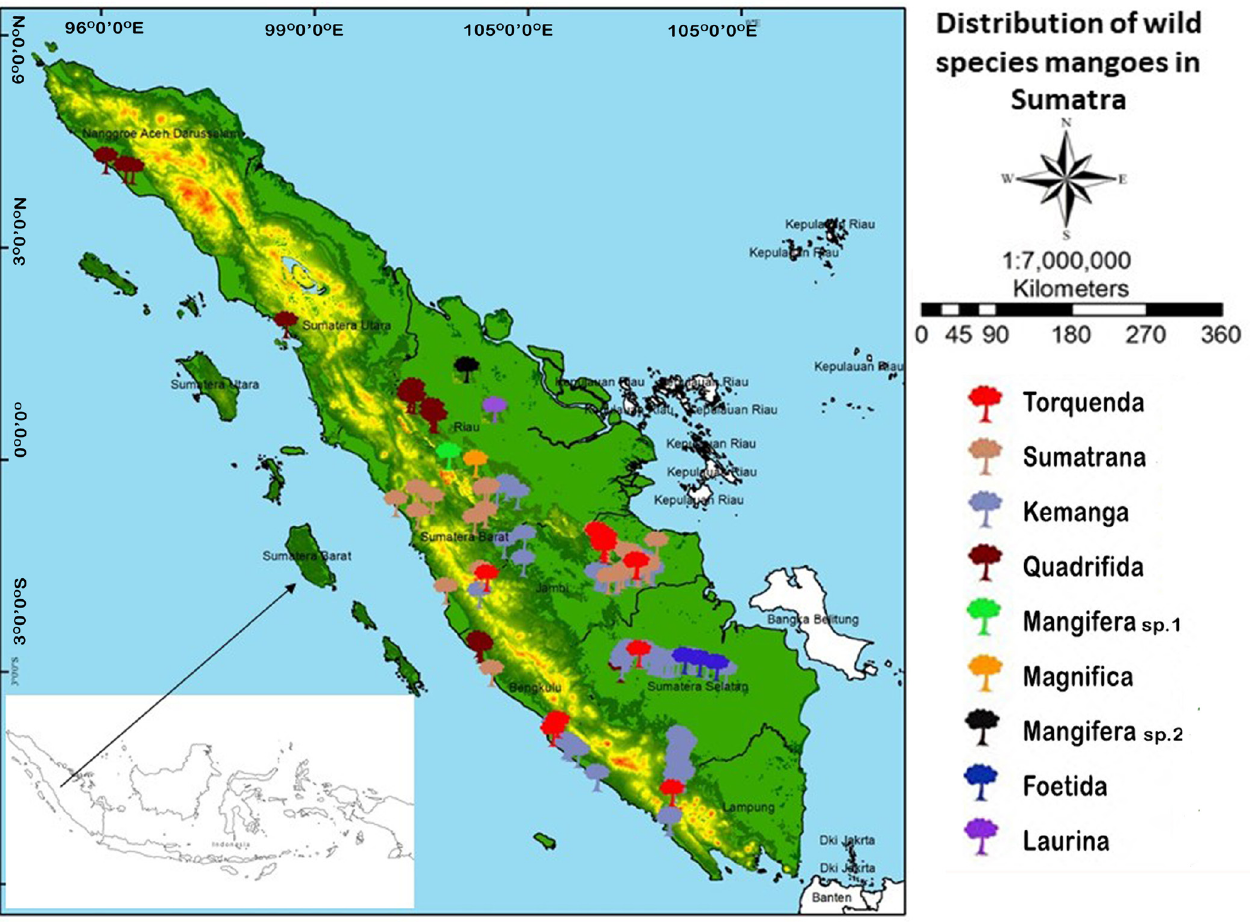
Figure 1. Distribution of the wild mango sources involved in this